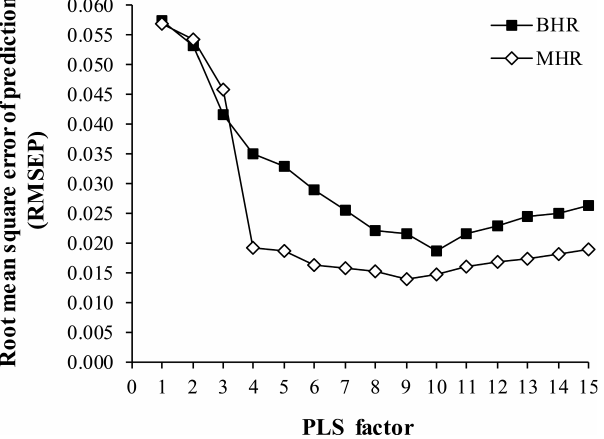
Fig. 5. Root mean square error of prediction versus PLS factors for BHR and MHR.